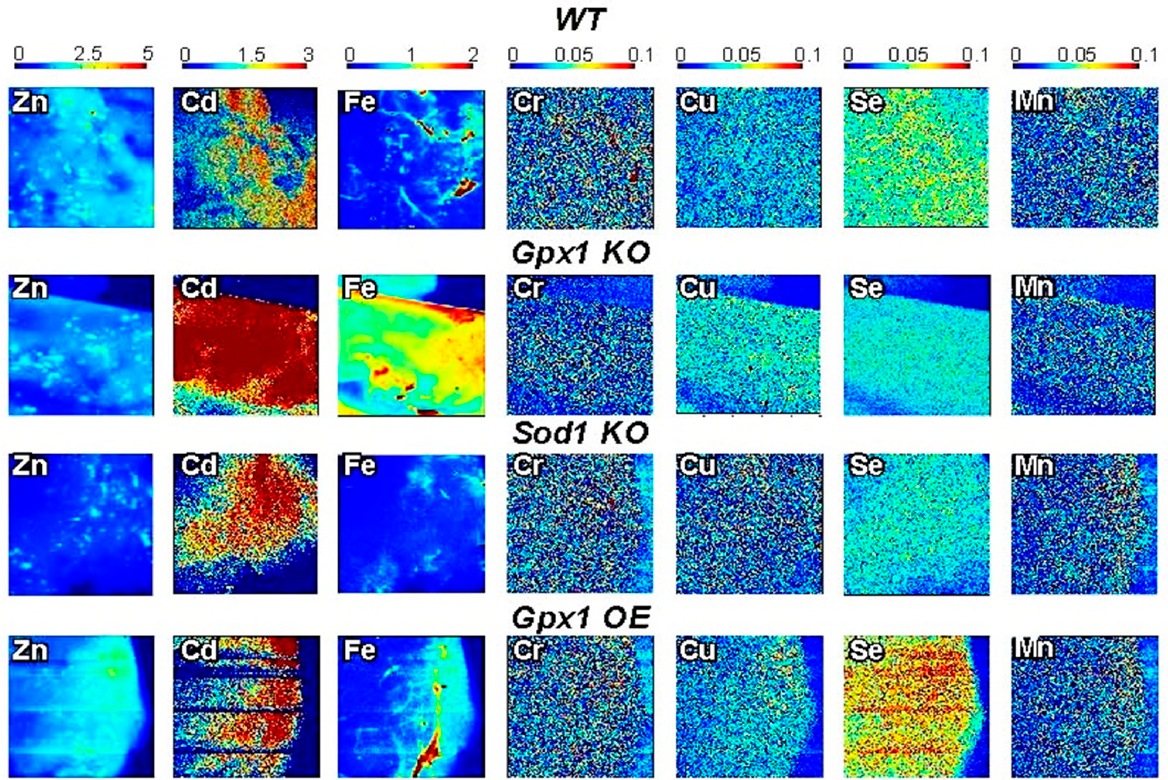
Figure 2. SXRF visualization of seven micronutrients in pancreatic tissue related to the mechanisms of insulin secretion. The redistribution of metals in freshly isolated pancreatic tissue in mouse models overexpressing or lacking major antioxidant enzymes Gpx1 and Sod1. Metal maps was acquired at a 20 µm resolution, and a 0.25 s/pixel dwell time using a focused, monochromatic incident X-ray beam of 12.2 keV. XRF data were processed with Praxes, a CHESS-developed software for image analysis.